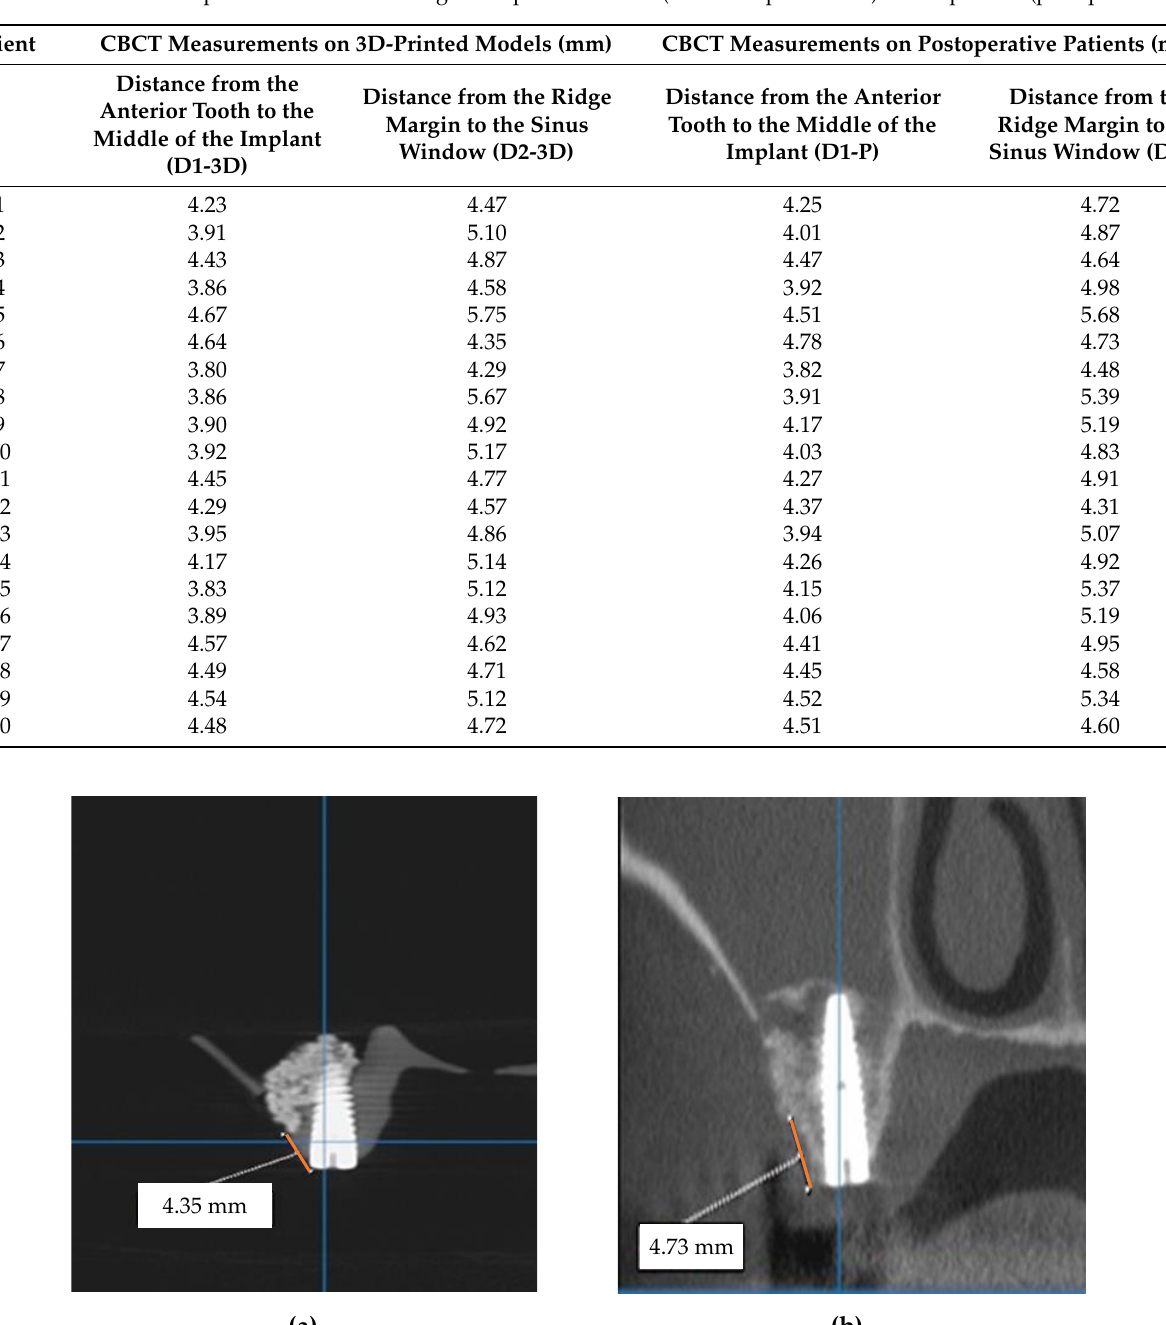
(b) Figure 8. Measurement of the distance between the top of the ridge and the lowest access cut at the buccal wall of the 231 Figure 8. Measurement of the distance between the top of the ridge and the lowest access cut at the buccal wall of the maxillary sinus (for patient number 6 in Table 1) on ( a ) the training CBCT model ( D2-3D ) and on ( b ) the postoperative 232 maxillary sinus (for patient number 6 in Table 1) on ( a ) the training CBCT model ( D2-3D ) and on ( b ) the postoperative CBCT ( D2-P ) cross-section. 233 CBCT ( D2-P ) cross-section. Table 2. Descriptive statistics regarding the distance from the anterior tooth to the middle of the Table 1. Measurements performed on CBCT images: 3D-printed models (rehearsed procedures) versus patients (postoperative). 234 implant following rehearsal procedures on 3D-printed models ( D1-3D ) compared to the distance Patient CBCT measurements on 3D-printed models (mm) CBCT measurements on postoperative patients (mm) from the anterior tooth to the middle of the implant following implant procedures on patients ( D1-P